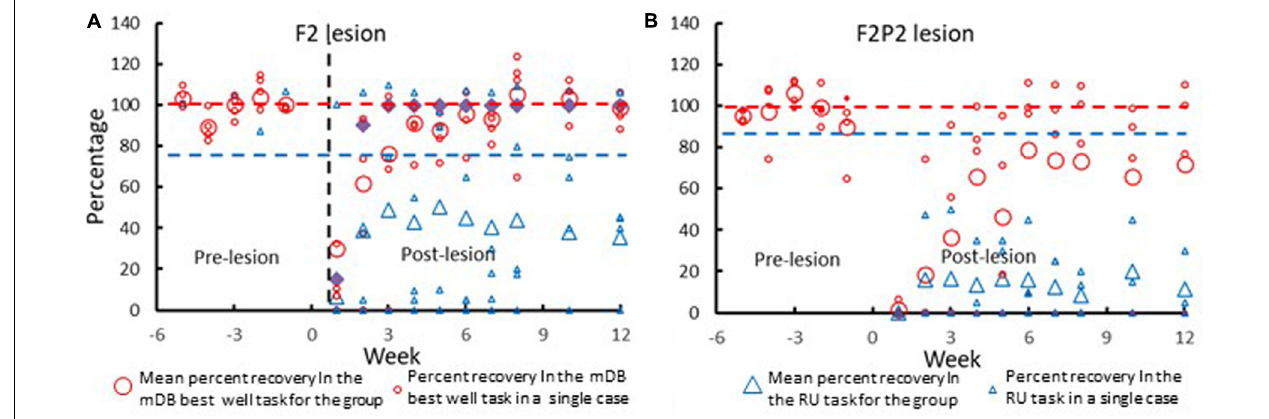
FIGURE 4 | Recovery of contralesional hand performance in the mDB and RU tasks in all F2 (A) and F2P2 (B) lesion cases. The large symbols show mean data across all subjects within the group. The smaller symbols show data from individual monkeys. Recovery of performance in the mDB best well task (red circles) was computed as the percentage ratio of post-lesion performance score/average prelesion performance score (over the last five pre-lesion tests) on the well with highest pre-lesion skill (best well). Recovery of spontaneous use of the contralesional hand in the RU task (blue triangles) is plotted as the %use of that hand in the post-lesion tests. The red dashed horizontal line represents average pre-lesion performance scores over the last five pre-lesion tests. The dashed blue horizontal line represents pre-lesion use of the preferred hand in the test of hand preference. Note that data for the RU task for SDM91 of the F2P2 lesion group was all zeros as this monkey never use the contralesional hand in the RU task. Similarly, SDM91 had very poor recovery in the mDB best well task as there were no attempts made to reach to and grasp the food target (performance score = 0) on most